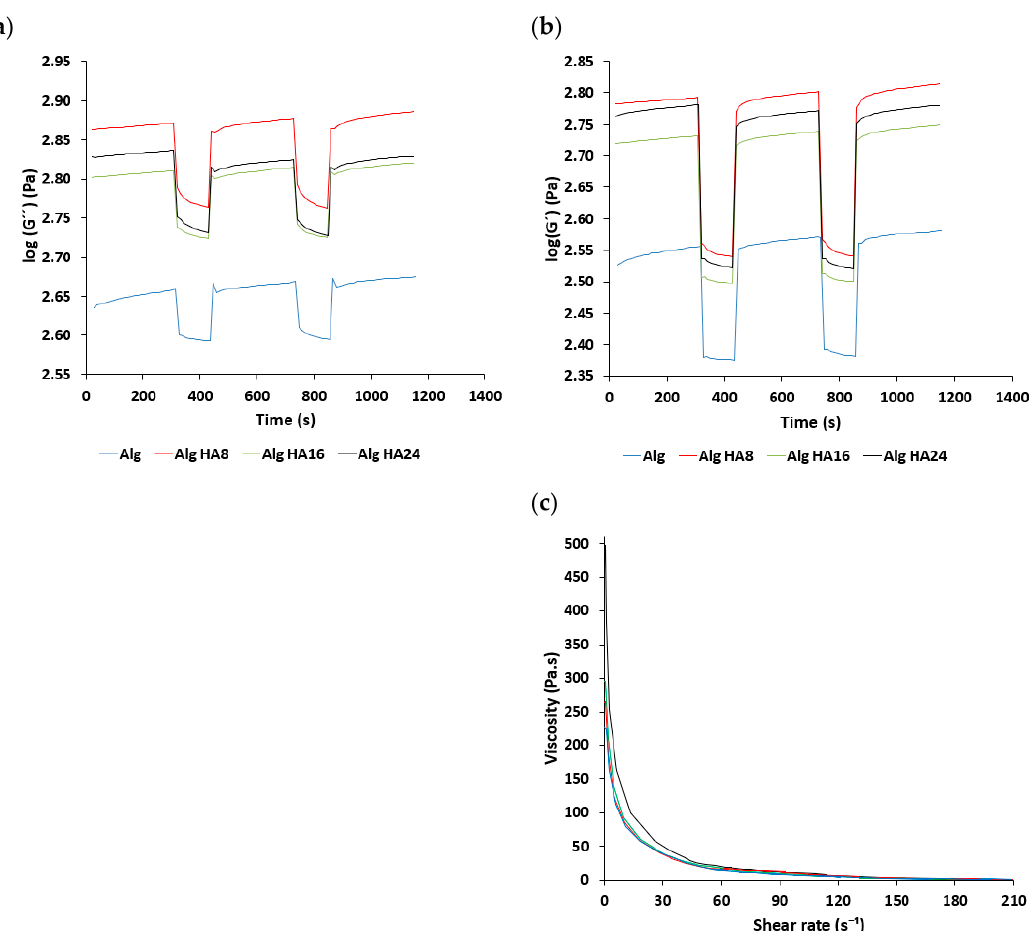
Figure 1. Rheological characterization of alginate-HA inks: ( a , b ) Time variation of storage and loss moduli and ( c ) overall viscosity variation with respect to the shear rate for different alginate-HA ink